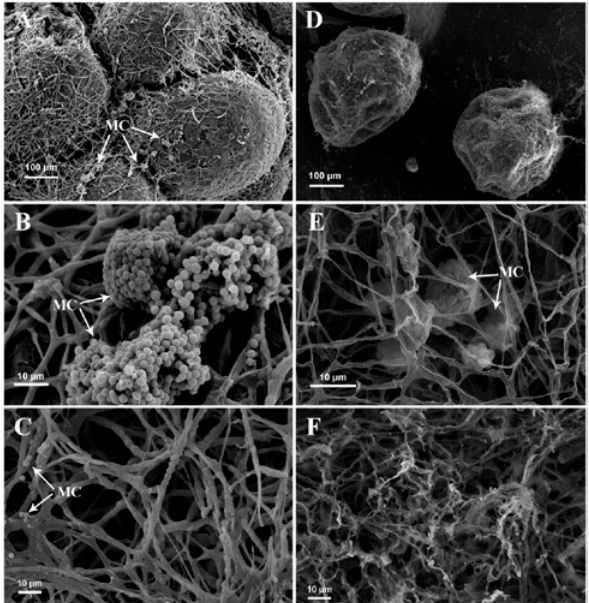
Figure 2. Scanning electron micrographs showing the antifungal effects of Bacillus amyloliquefaciens GGA on the morphology of Sclerotium cepivorum S6 in the dual culture test. A, normal spheri- cal sclerotia with intact, rough-surfaced external rind layers; B, small globose to subglobose rough-walled microconidia on myce- lium emerging from sclerotic; C, typical well-developed branched aerial hyphae; D, wrinkled sclerotia with depressions on their sur- faces and ruptured rinds; E, distorted and shrunken microconidia; and F, twisted, curled and collapsed hyphae. MC =